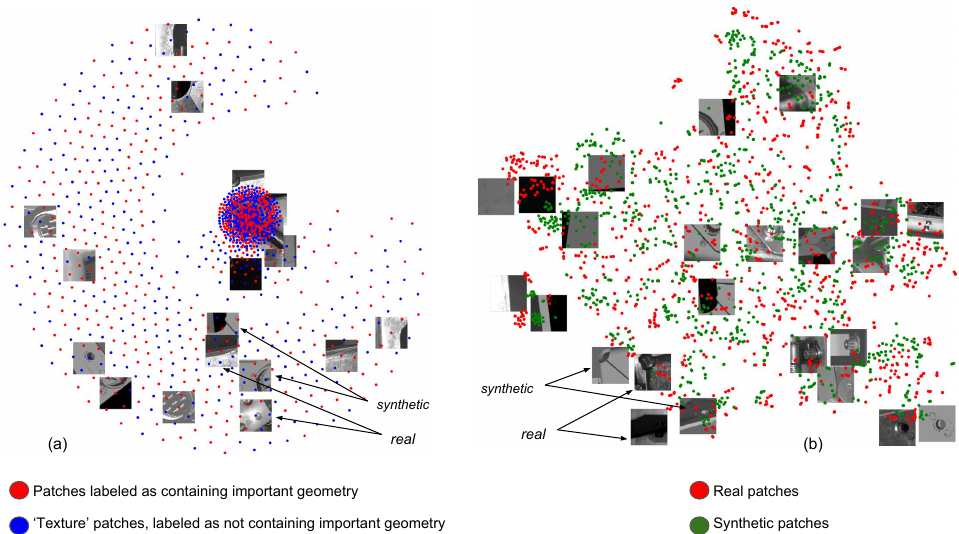
Figure 5. Visualization of features extracted from synthetic and real patches after bootstrapping ( a ) and triplet-loss training ( b ) using t-SNE [31]. After bootstrapping, the mappings of real and synthetic patches are close by and intermeshed in the feature space, a good step toward solving domain shift problem, as can be seen from the patches visualized on top of their mapped point features. After triplet-loss training, we see that real and synthetic patches with similar geometry are mapped to nearby locations.